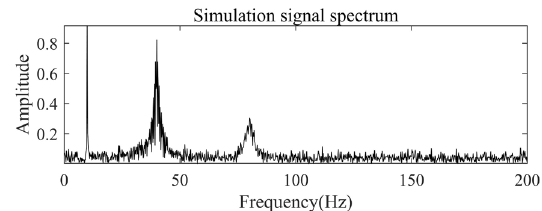
Figure 3 Simulation signal spectrum